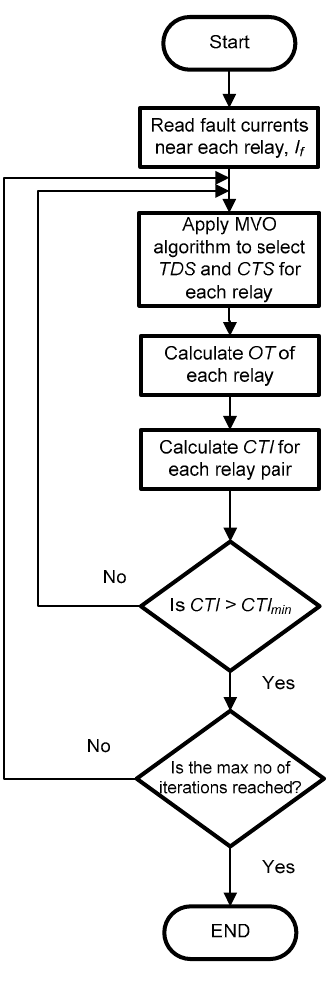
Figure 5. The flowchart of the proposed algorithm.